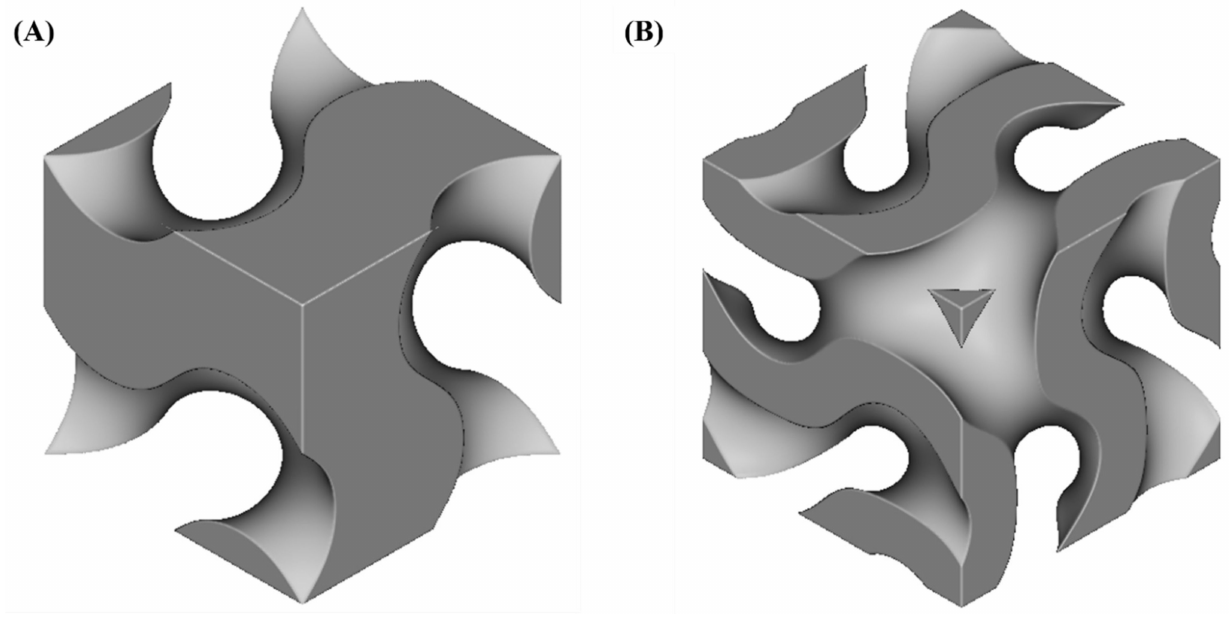
Figure 2. Gyroid unit cell: ( A ) network; ( B ) matrix (shell).